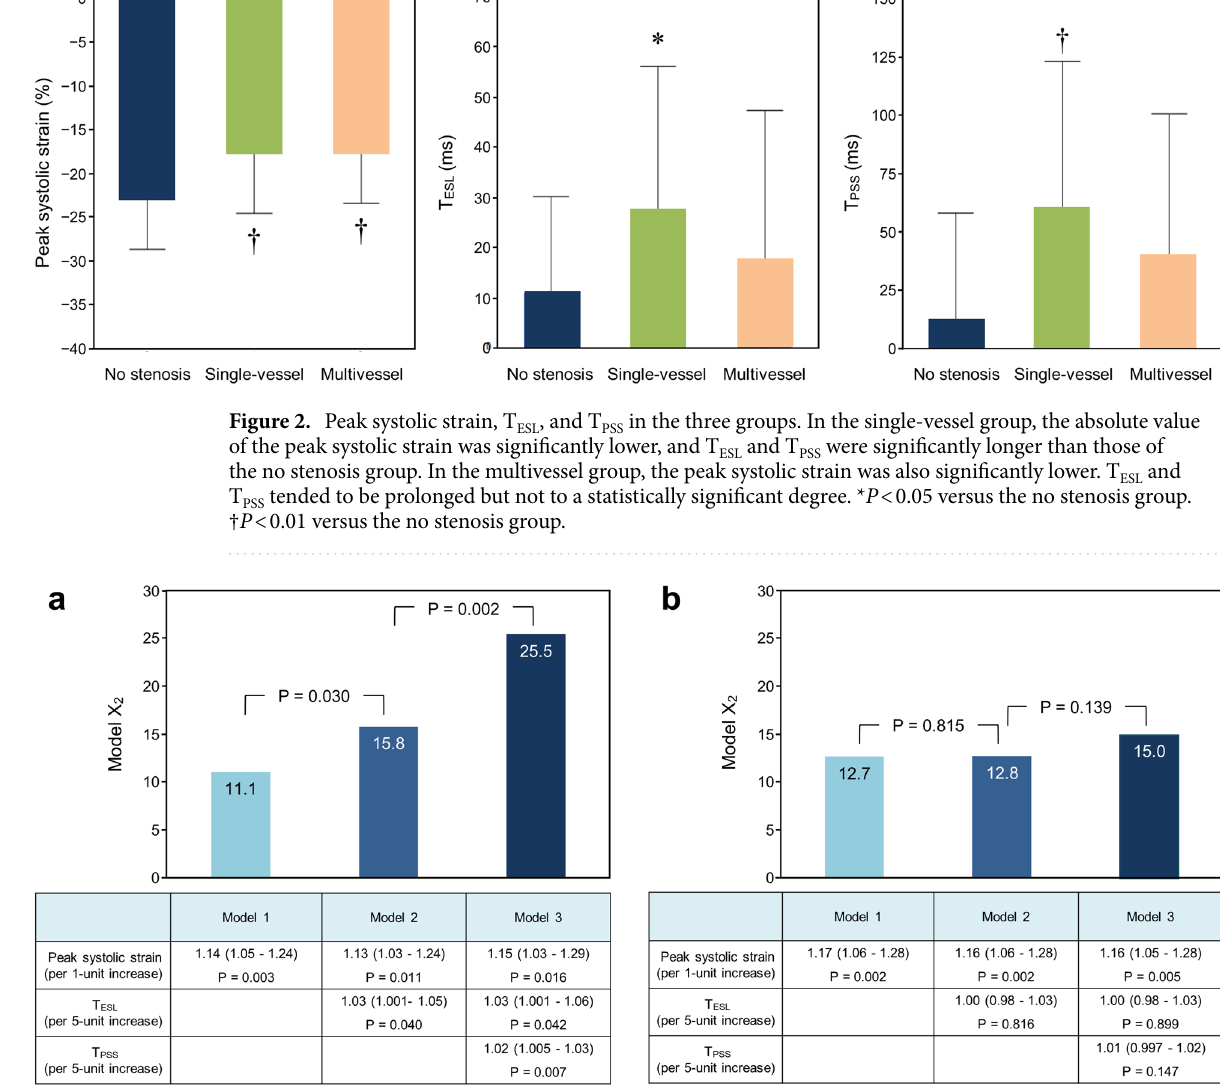
Figure 3. Incremental value of T ESL and T PSS by multivariable logistic regression models. ( a ) In the single-vessel group, the peak systolic strain was a significant parameter in diagnosing left anterior descending artery (LAD) stenosis, and T ESL and T PSS were also independent determinants in the logistic regression analysis. The addition of T ESL and T PSS to the peak systolic strain significantly increased the model power. ( b ) In the multivessel group, the peak systolic strain was also a significant parameter in diagnosing LAD stenosis. However, the addition of T ESL and T PSS did not generate a significant increase in the model power. The tables present the odds ratios and 95% confidence